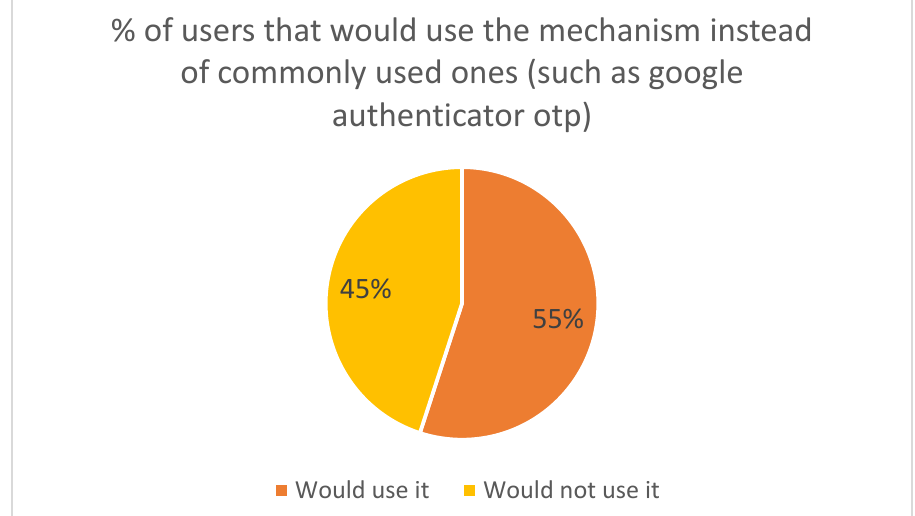
Figure 12. User acceptance results.